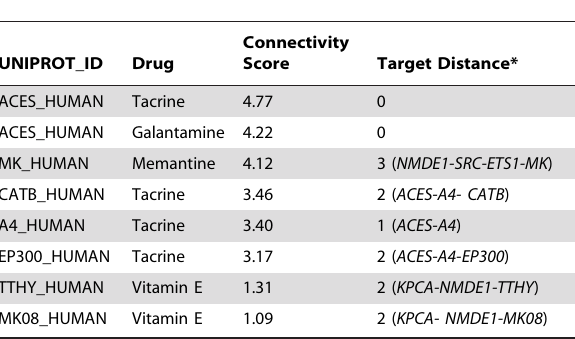
Table 3. Cross-validation of protein-drug relationships identified in the AD connectivity map with target-drug relationships of AD drugs in